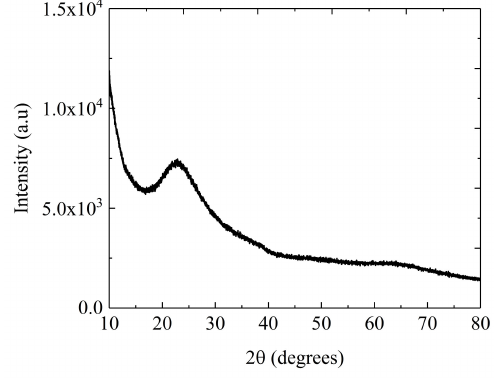
Figure 1. XRD pattern of Te-5 glass.